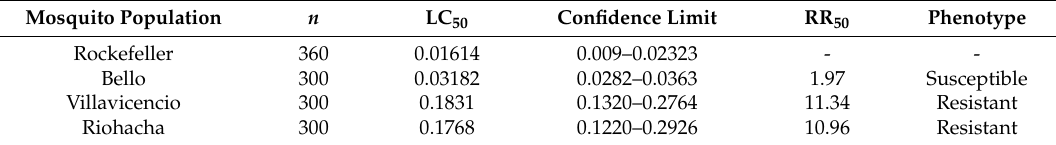
Table 2. Resistance ratio to λ -cyhalothrin of Aedes aegypti populations studied in Colombia. Mosquito Population LC 50